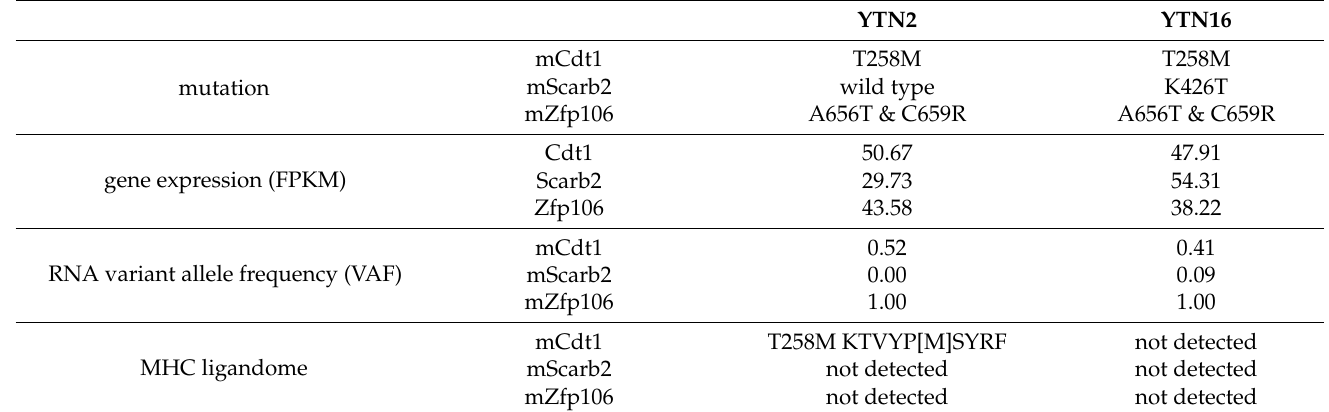
Table 1. Comparison of YTN2 and YTN16 in terms of